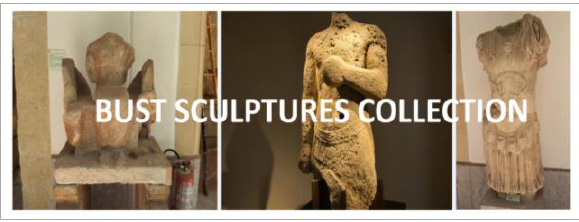
Figure 8. The bust sculptures category: step 1